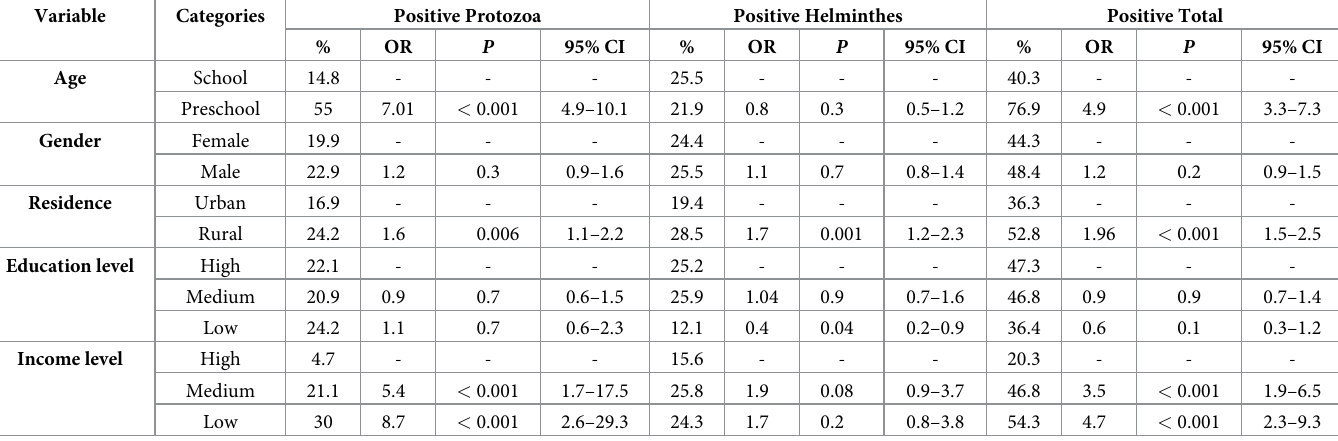
Table 3. Univariate regression analysis for association between the socio-demographic characteristics and prevalence of detected IPIs in examined children in this study.